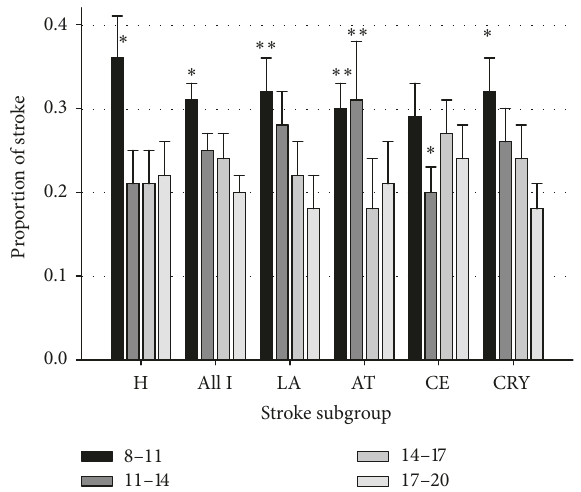
Figure 3: Proportion of stroke onset during diurnal period in subgroups of stroke. H, hemorrhagic; all I, all ischemic; LA; AT; CE; CRY. Black bars = 8–11; dark gray bars = 11–14; gray bars = 14–17; light gray bars = 17–20. ∗ indicates at least 𝑝 < 0.005 from other intervals; ∗∗ indicates at least 𝑝 < 0.01 from afternoon